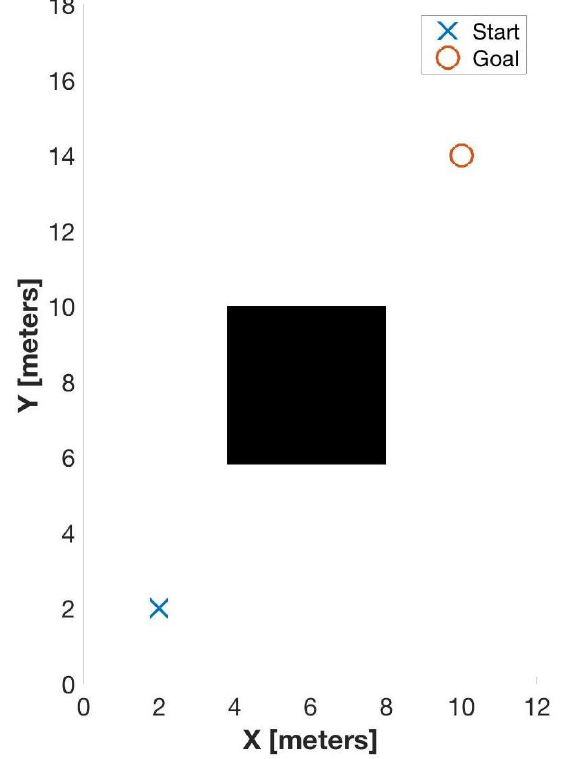
Figure 8. Testbed for Case I (obstacle represented by the black box).